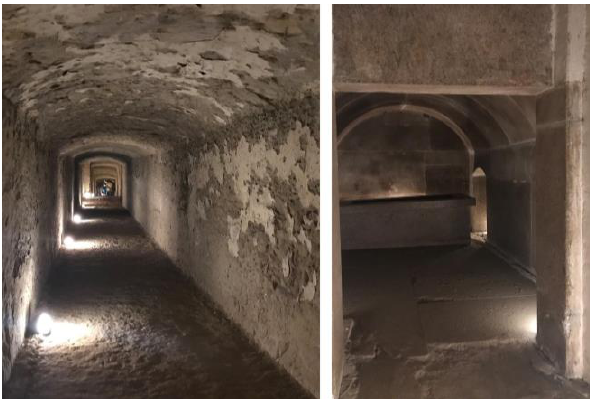
Figure 12. Lahun Pyramid from the inside after the restoration and the opening in June